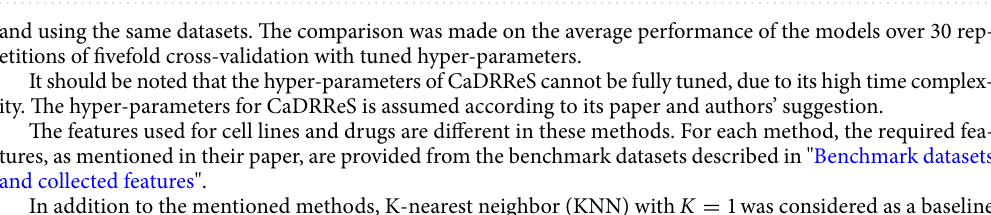
Figure 3. Drug-wise PCC for 4 drugs in GDSC. The computed PCC is illustrated in lower right corner of each